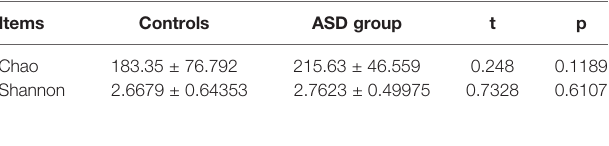
TABLE 3 | Chao1 and Shannon indexes in Controls and ASD group.